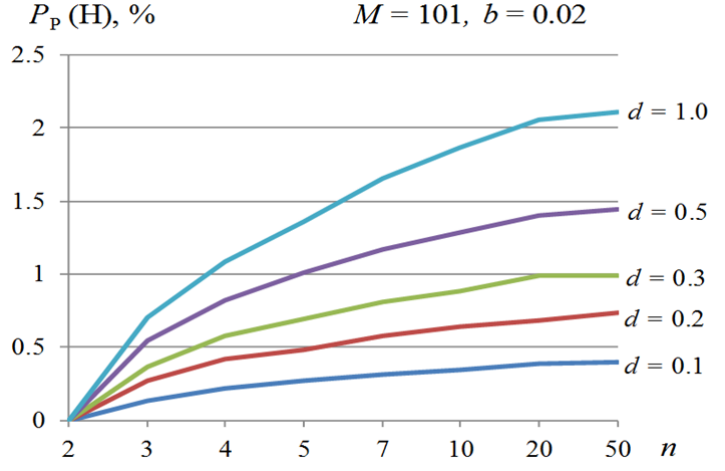
Figure 5. Parameter P dependence to M and n for Hamilton p